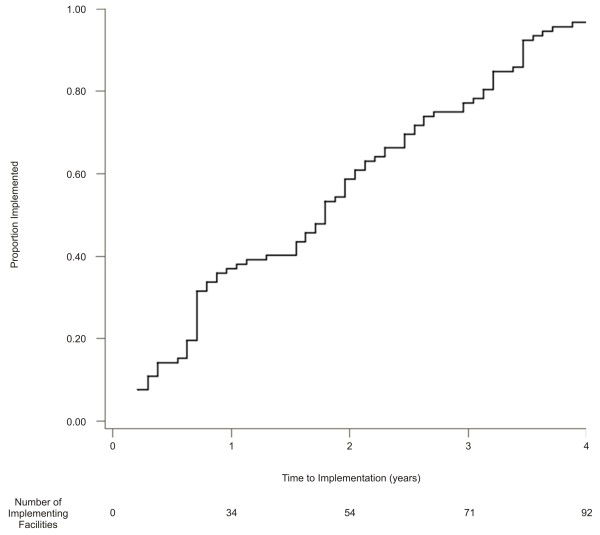
Proportion of Facilities that Implemented Automated eGFR Reporting over time. For the facilities that implemented automated eGFR reporting during the study period (n=92), this line plot depicts time to initial implementation measured in years from the date of software availability.